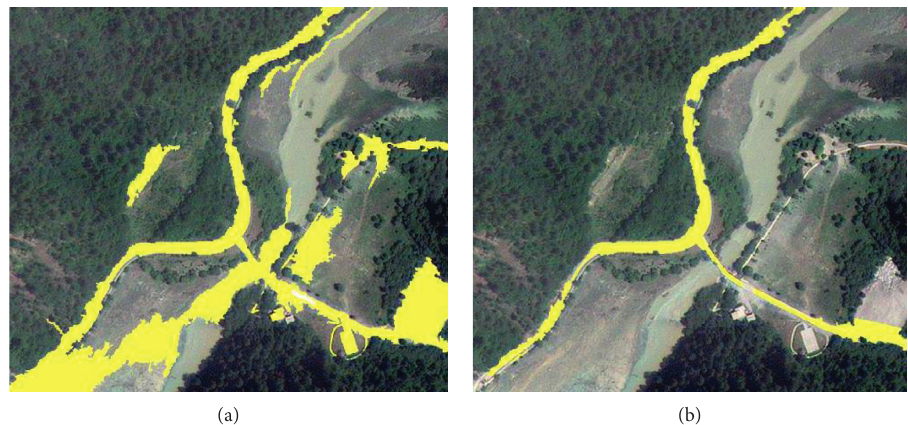
Figure 5: Classification results comparison. (a) Original classification result. (b) Buffer-constrained classification